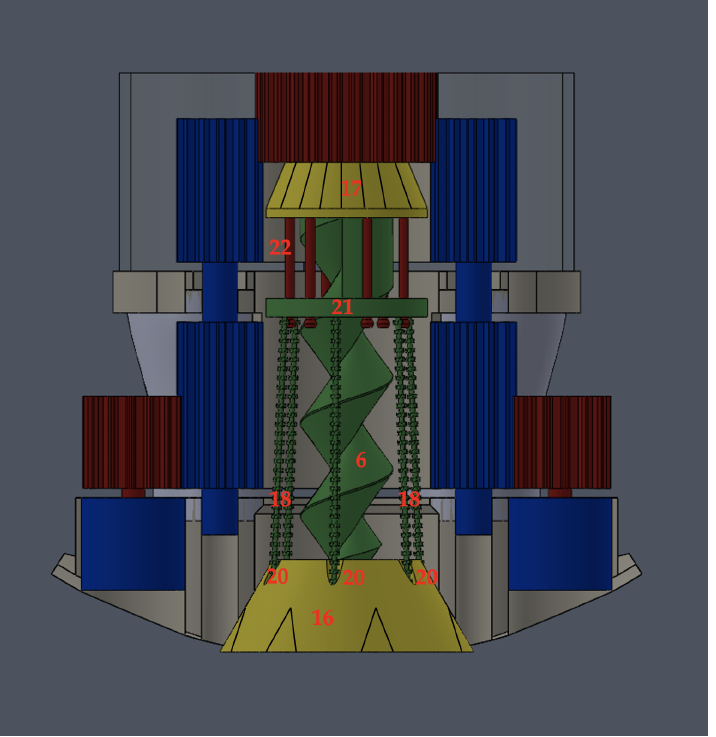
Figure 7. RAATM wire root array sub-assembly components in the stowed